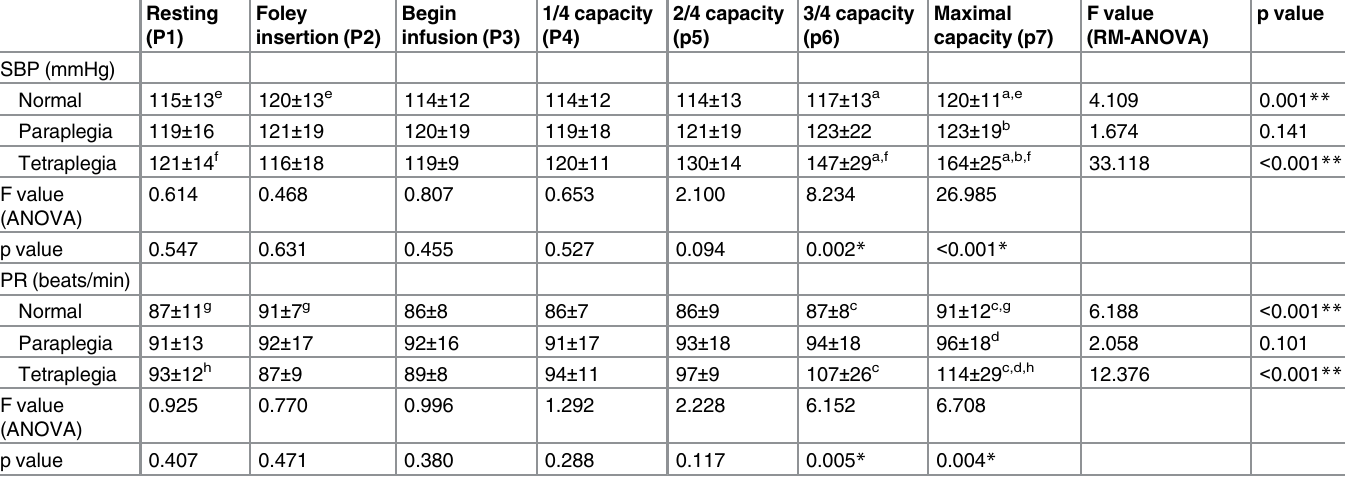
Table 2. Blood pressure and pulse rate changes at rest, Foley insertion and during the process of bladder infusion. Resting